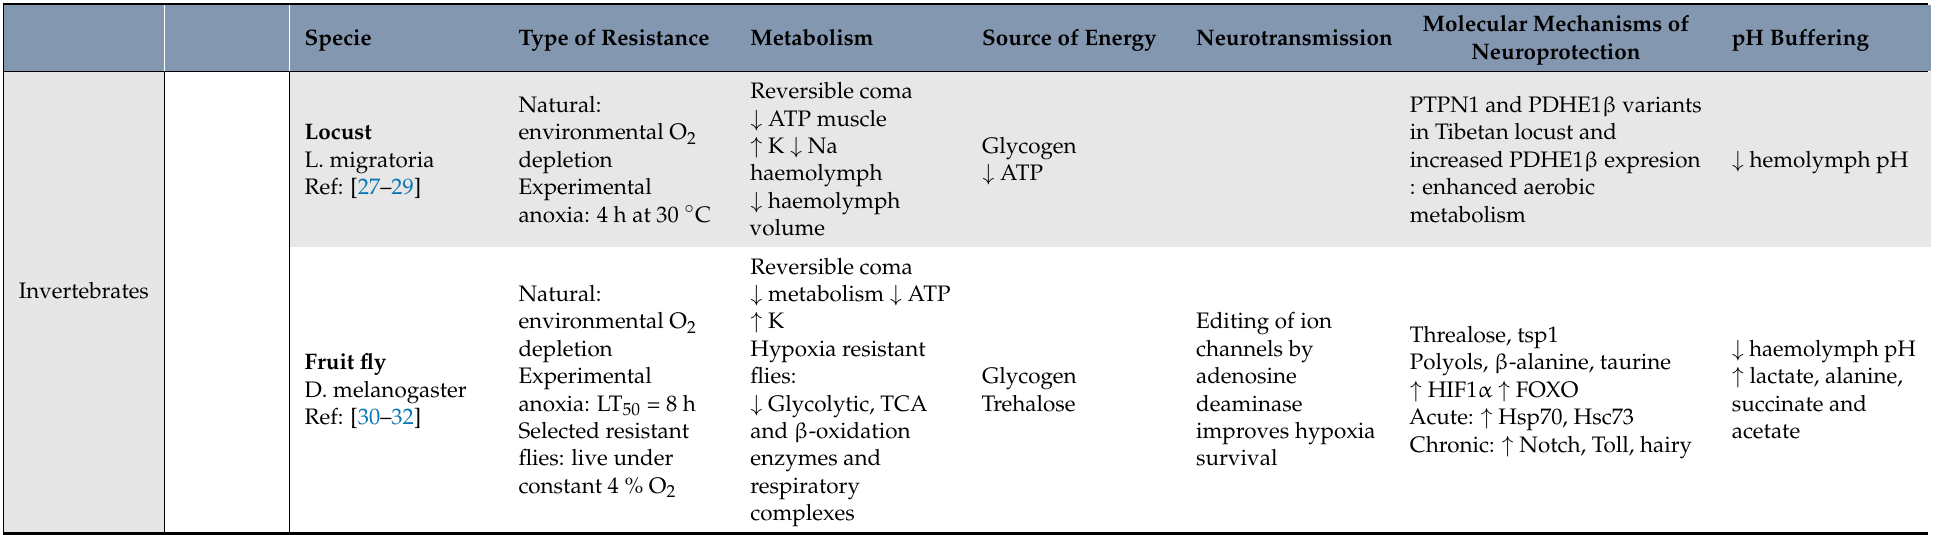
Table 1. Mechanisms contributing to hypoxia resistance described for different tolerant species. Abbreviations: ADP: adenosine diphosphate; Akt: protein kinase B; ATP: adenosine triphosphate; AR: adenosine receptors; Bax: Bcl2 Associated X protein; Bcl-2: B-cell lymphoma; DOR: delta-opioid receptors; EGLN1: Egl-9 Family Hypoxia Inducible Factor 1;